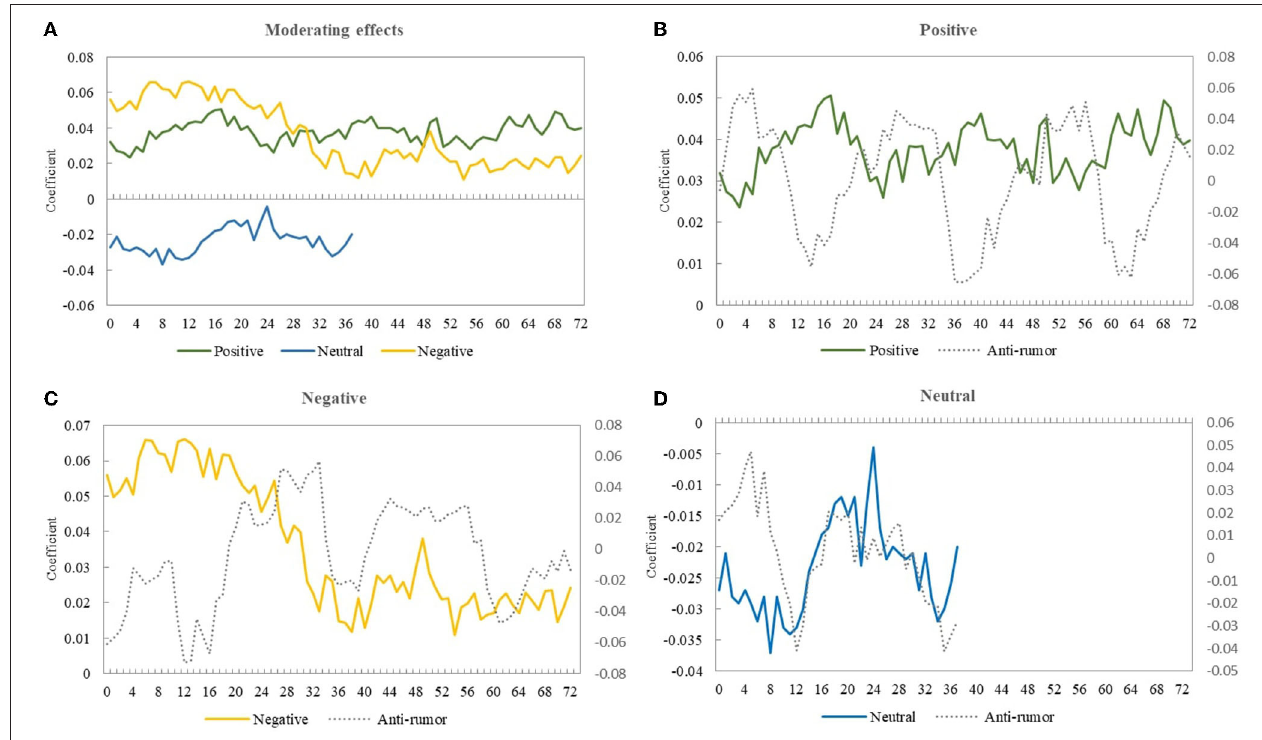
FIGURE 3 | The moderating effect of rumor refutation over time. (A) Represents the trend of the moderating effect of positive, neutral and negative information over time. (B–D) Represent the comparison of the three types of information and the corresponding moderating effects of refuting rumors.